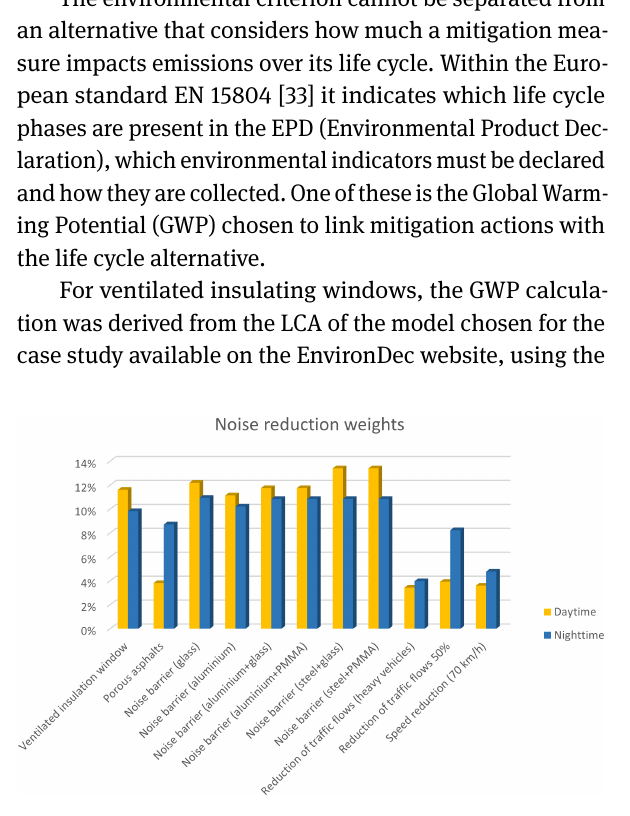
Figure 8: Comparison of noise abatement weights in the two scenar- ios